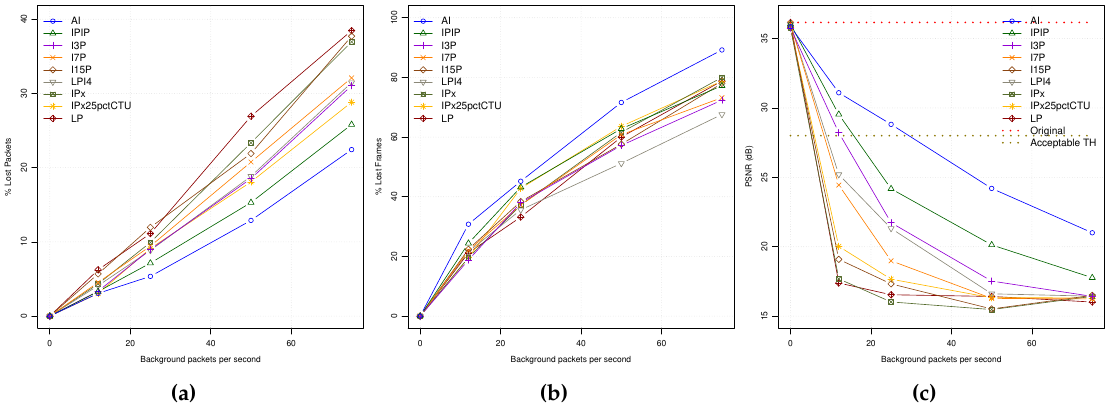
Figure 4. QoE statistics for all the encoding modes: ( a ) PLR. ( b ) FLR. ( c ) PSNR.